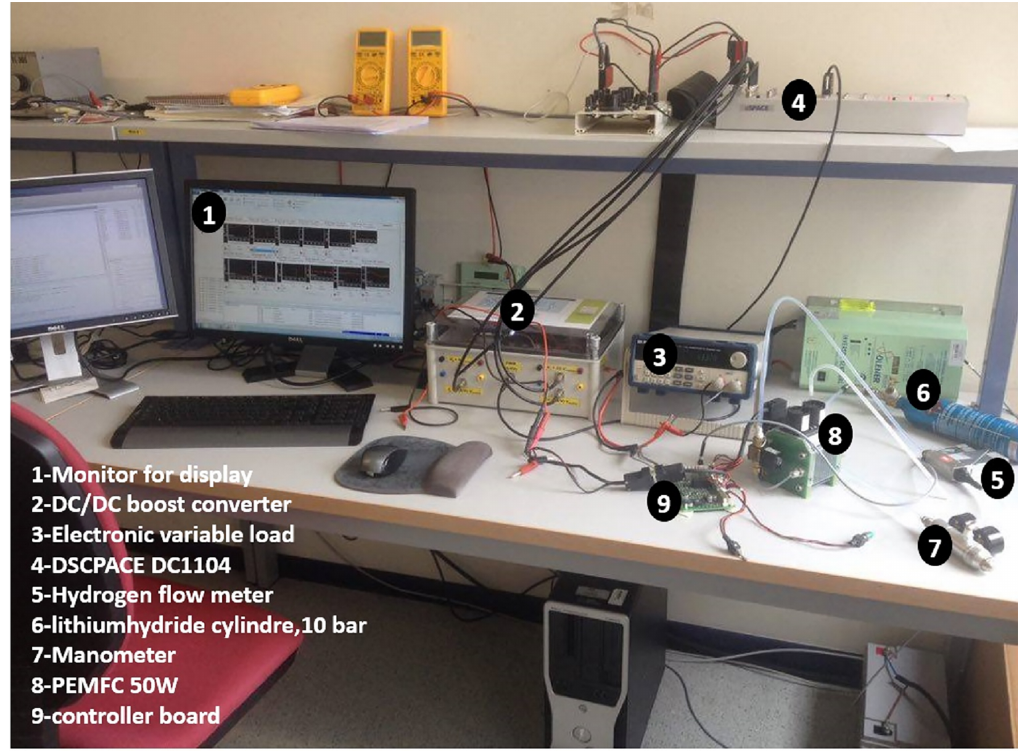
Figure 5. Integrated experimental